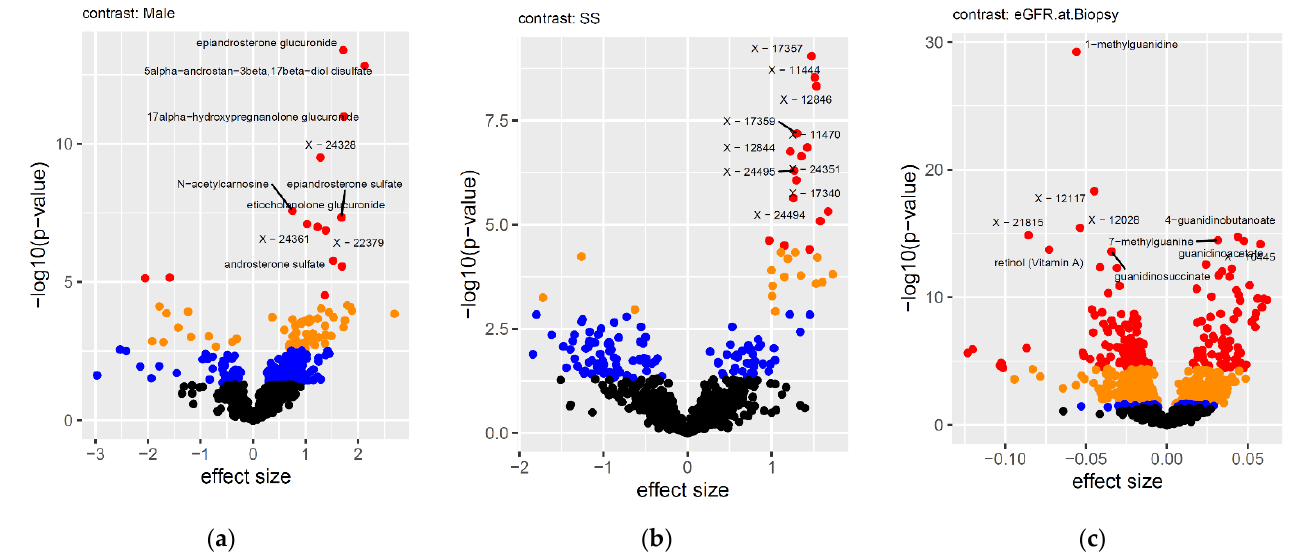
Figure 3. Volcano plots of ( a ) sex, ( b ) maintenance immunosuppressive therapy without steroids (SS) or with steroids, and ( c ) eGFR at biopsy. The significance level of the associations is indicated by color as follows: black = not significant, blue = p -value < 0.05, orange = false discovery rate (FDR) < 5%, red = Bonferroni level, p -value < 0.05/1276.